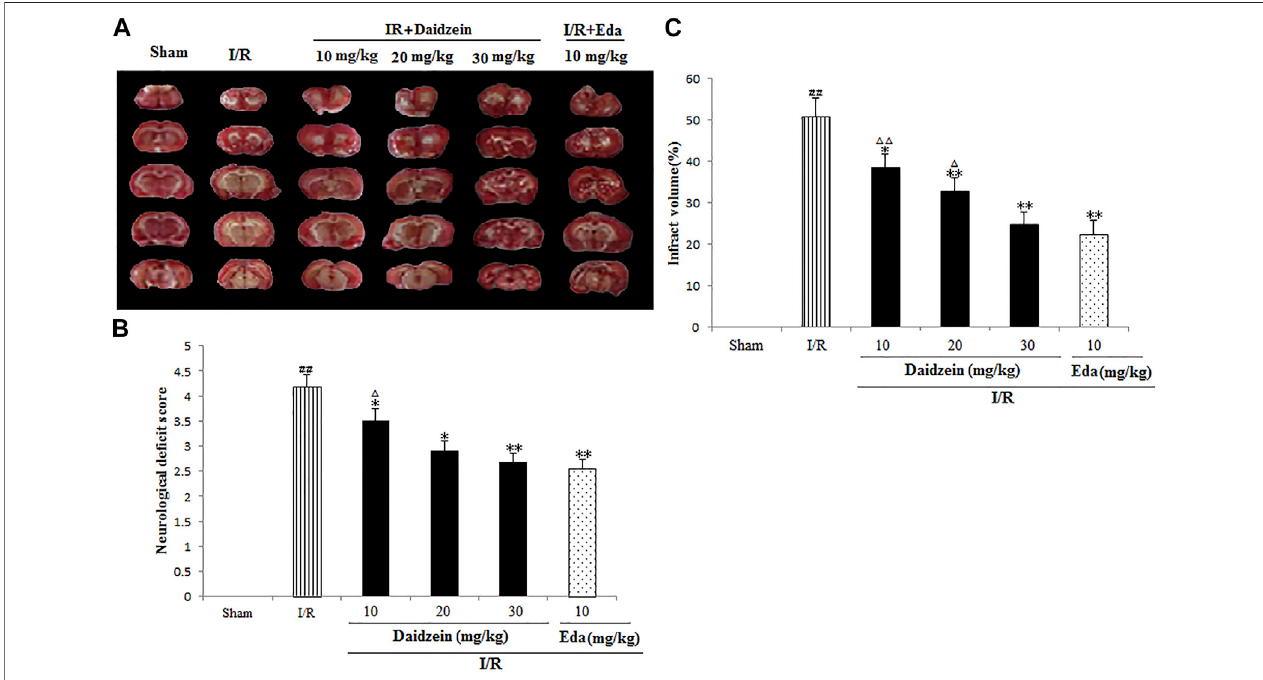
FIGURE3| Daidzeinattenuatedtheneurologicalde fi citvaluesandinfarctvolumeofafterI/R. (A) Thein fl uenceexertedbydaidzeinonneurologicalde fi citvalues (B) Representative brain sections stained with TTC; (C) The in fl uence exerted by daidzein on the infarct volume. ## p < 0.01, in contrast to the Sham group; * p < 0.05, ** p < 0.05 vs. I/R; △ p < 0.05, △△ p < 0.01, compared with the Eda group.